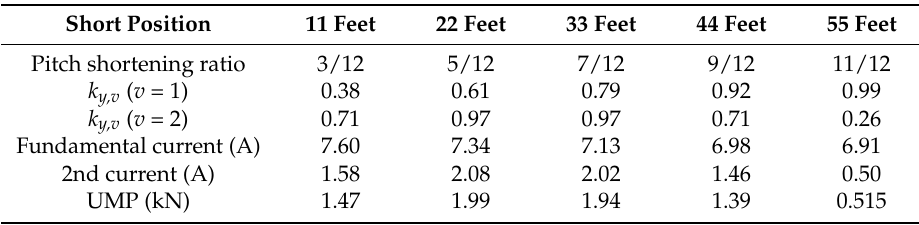
Table 5. UMP and the RMS of stator harmonic current when field concentric coils with different pitches undergo the same turn short